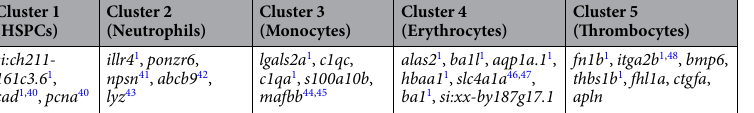
Table 1. Zebrafish. High weight genes computed using the high weight connections to the latent dimensions with the highest percentage for differentiating the corresponding cell type. Using references from scientific literature each cluster found using DiffVAE is mapped to a cell